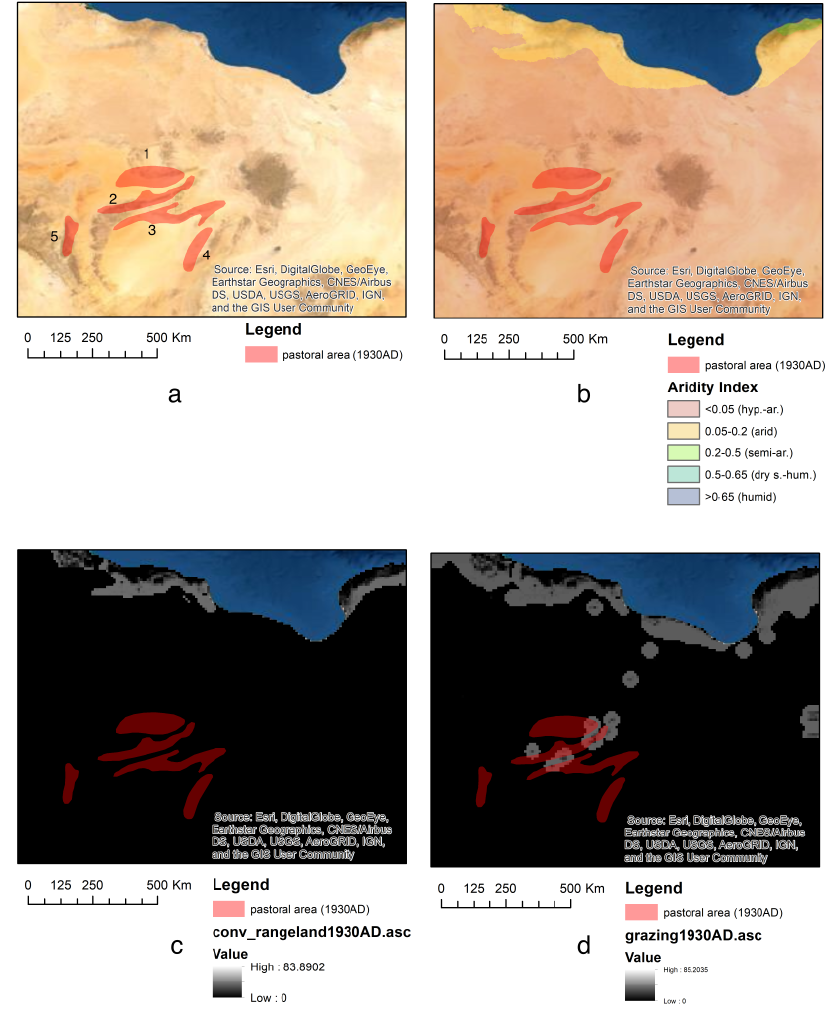
Figure 4. Pastoral areas in Fezzan (area 1 in Figure 1) according to ethnographic sources [35–37]: ( a ) the five areas discussed in this paper, key: 1—Wadi Shati, 2—Wadi el Ajal, 3—Wadi Berjuj, 4— Wadi Hikma, and 5—Wadi Tanezuft; ( b ) in relation to the Aridity Index values; ( c ) superimposed to rangeland values; and ( d ) superimposed to grazing values. Legend in ( c , d ) displays the land use according to Klein [33]. Spatial resolution 5 arc-minutes (maps elaborated with